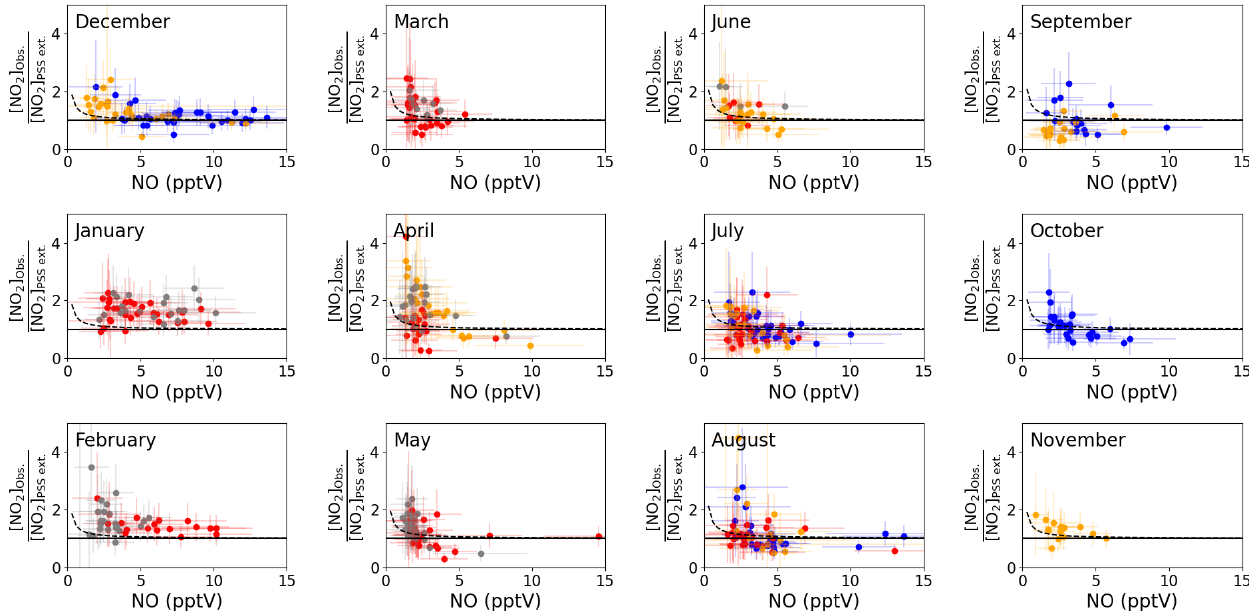
Figure 4. Monthly plots of midday (12:00–15:00UTC, local + 1) daily averages of [NO 2 ] Obs . / [NO 2 ] PSS ext . vs. the measured NO mixing ratio. The solid lines represent a ratio of 1 between the observed and predicted NO 2 . The error bars represent ± 2 σ uncertainty on the calculated ratio and measured NO. The colours represent the year of the measurements: 2017 = blue, 2018 = red, 2019 = orange, 2020 = grey. The dashed lines represent ([NO 2 ] PSS ext . + 0 . 95pptV) / [NO 2 ] PSS ext . to visualise the effect of a NO 2 artefact of 0.95pptV on the ratio using the average measured j NO 2 and O 3 and modelled HO 2 and RO 2 for each month and the annually average measured IO and BrO for the CVAO. The uncertainty of each data point has been determined from measurement uncertainties in Table 2, the uncertainties in the measured BrO and IO described in the text, and 20% uncertainty on all the rate coefficients. The uncertainty in the modelled radicals has not been